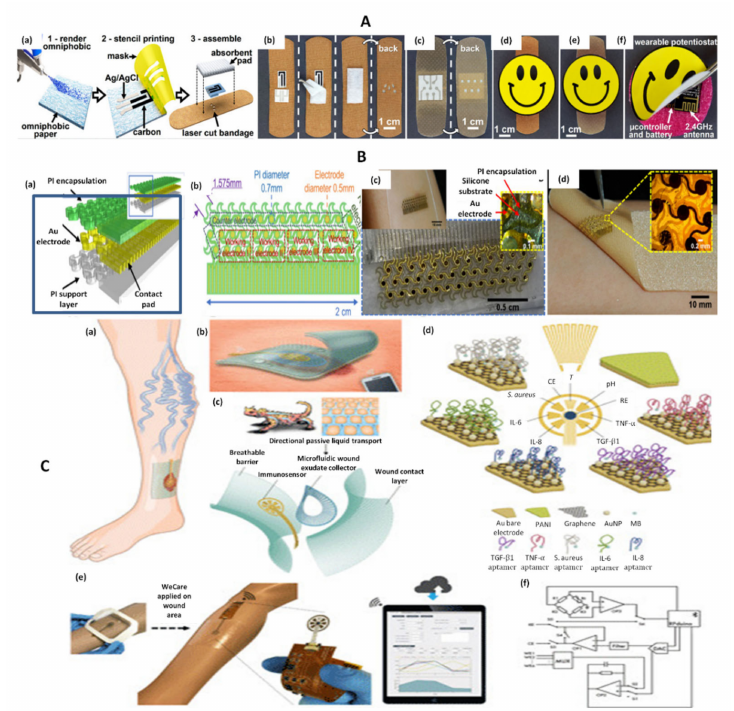
Figure 3. ( A ) Fabrication protocol for omniphobic paper smart bandage (OPSB) fabrication and assembly process. ( a ) Schematic diagram of the fabrication of OPSBs with: (1) Whatman#1 paper rendered omniphobic by spraying a 2% solution of RF SiCl 3 in isopropyl alcohol; (2) stencil printing is used to pattern flexible conductive electrodes using carbon and Ag/AgCl inks; (3) openings are laser cut on the adhesive layer of the bandage to interface the wearable potentiostat with the paper-based sensors in the OPSB. OPSBs are assembled by placing the paper-based sensors between the adhesive layer and the absorbent pad of the commercial bandages. ( b ) OPSBs used to monitor UA and pH levels in open wounds. ( c ) OPSBs used for the early detection of pressure ulcers. ( d , e ) Interfacing of the wearable potentiostat with OSPBs for monitoring open wounds and detecting 12 pressure ulcers, respectively. ( f ) Packaging of the electronics in the rechargeable, wearable Potentiostat Reprinted (adapted) with permission from Reference [36] Copyright 2021 Elsevier. ( B ) Skin-inspired gold electrodes ( a ); schematic diagram of the flexible device ( b ); schematic diagram with dimensions ( c ); image of the sensor on polymeric wound dressing (Walgreens—Silicone Scar Sheets) ( d ); image of the sensor on a textile-silicon bandage (ScarAway—Silicone Scar Sheets) Reprinted (adapted) with permission from Reference [38]. Copyright 2021 Elsevier. ( C ) Schematic representation of a multiplexed immunosensing system for chronic wound monitoring. ( a ) Illustration of a biomarker analytical dressing applied onto an open wound of patients with venous ulcer for in situ surveillance. ( b ) Illustration of a thin, soft, biomarker analytical dressing (VeCare) that allows normal skin function allowing the penetration of oxygen inside but also the evacuation of moisture vapor outside. Data was wirelessly transmitted to a mobile system over Bluetooth Low Energy. ( c ) Envisioned biomarker analytical dressing constituting of a perforated wound contact layer, a microfluidic wound exudate collector, an immunosensor, and a breathable barrier. The microfluidic collector was inspired by the skin of Texas horned lizard enabling predetermined flow direction toward the lizard’s snout defying gravity. ( d ) Schematic representation of the sensors applied for the detection of TNF- α , IL-6, IL-8, TGF- β 1, S. aureus , pH, and temperature. PANI = polyaniline; MB = methylene blue; RE = reference electrode; CE = counter electrode. ( e ) VeCare prototype for envisioned chronic wound monitoring. The prototype was applied to a leg dummy as a demonstration. The immunosensor interfacing with a wireless portable analyzer fabricated on a flexible printed circuit board. A mobile application providing a graphical user interfaceas a one-stop patient’s profiles, medical records, data recording, data analysis, and result visualization system is shown. ( f ) Hardware block diagram for the VeCare platform. WE1 = working electrode 1; MUX = multiplexer Adapted from Reference [27] (Open